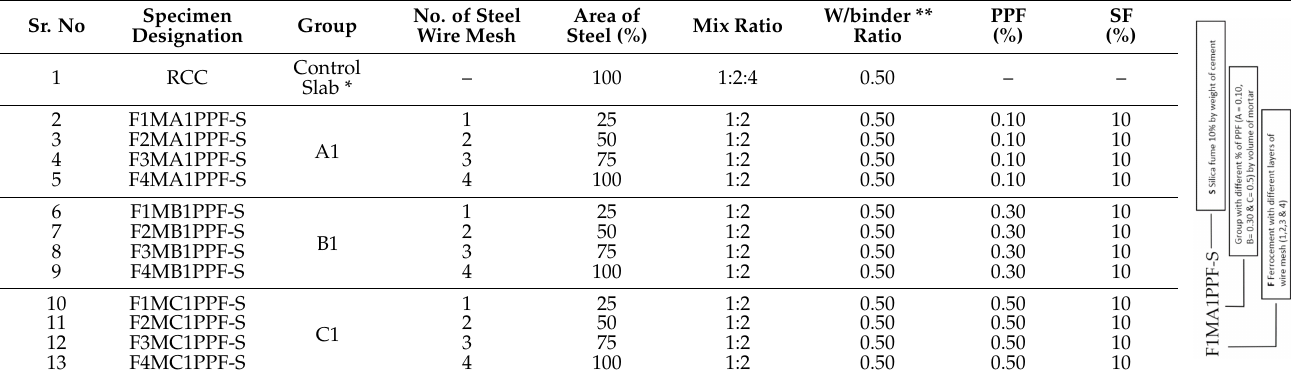
Table 5. Details of ferrocement slabs cast according to the mix design.